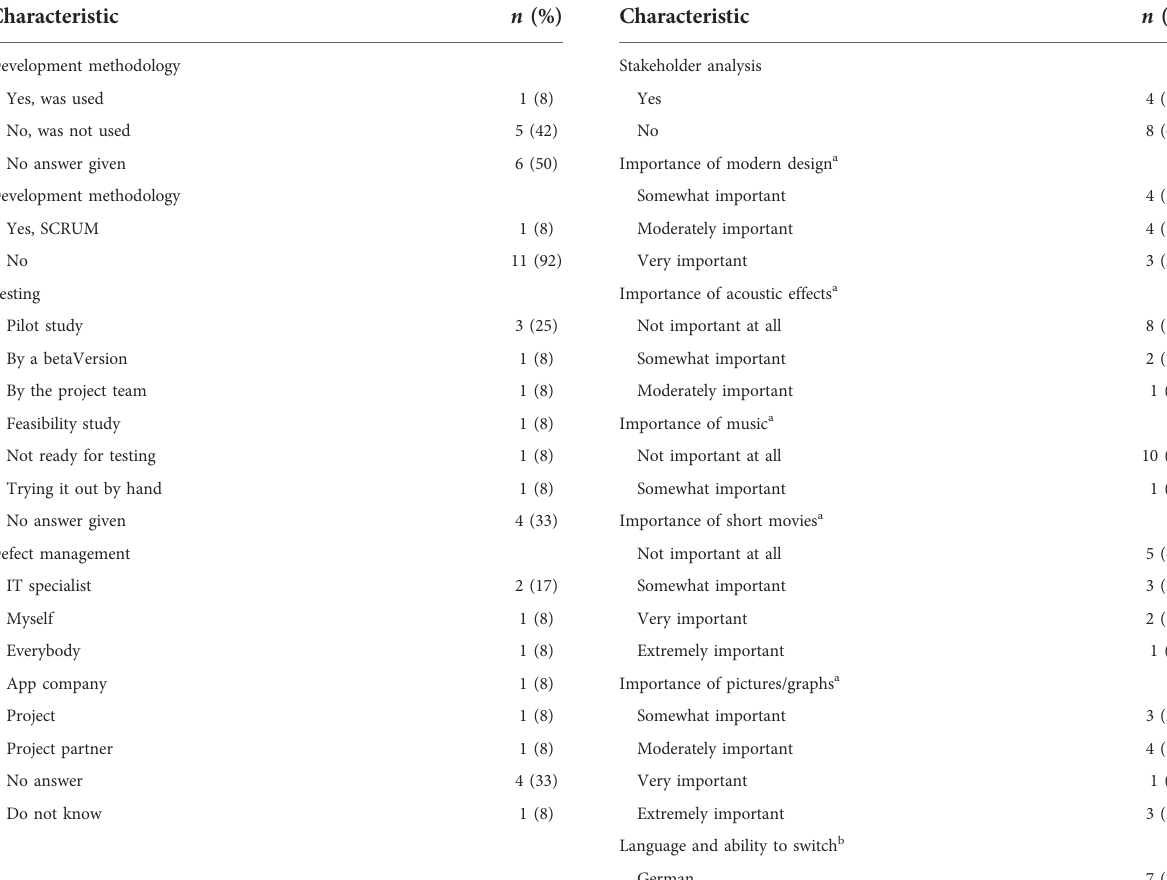
TABLE 3 Methodology used in app development ( N =12). TABLE 4 App requirements and features ( N